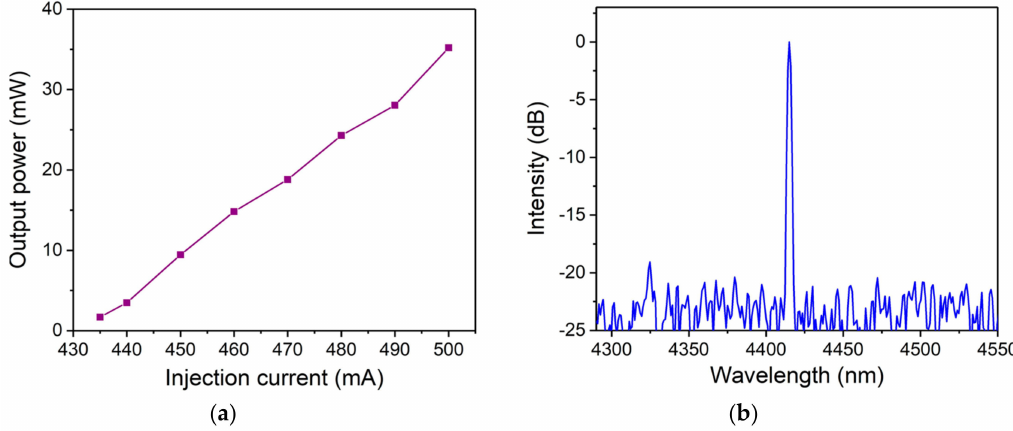
Figure 2. ( a ) The fixed wavelength quantum cascade laser (FW-QCL) output power as a function of at injection current. ( b ) The emission spectrum of the FW-QCL with a 35.2 mW optical